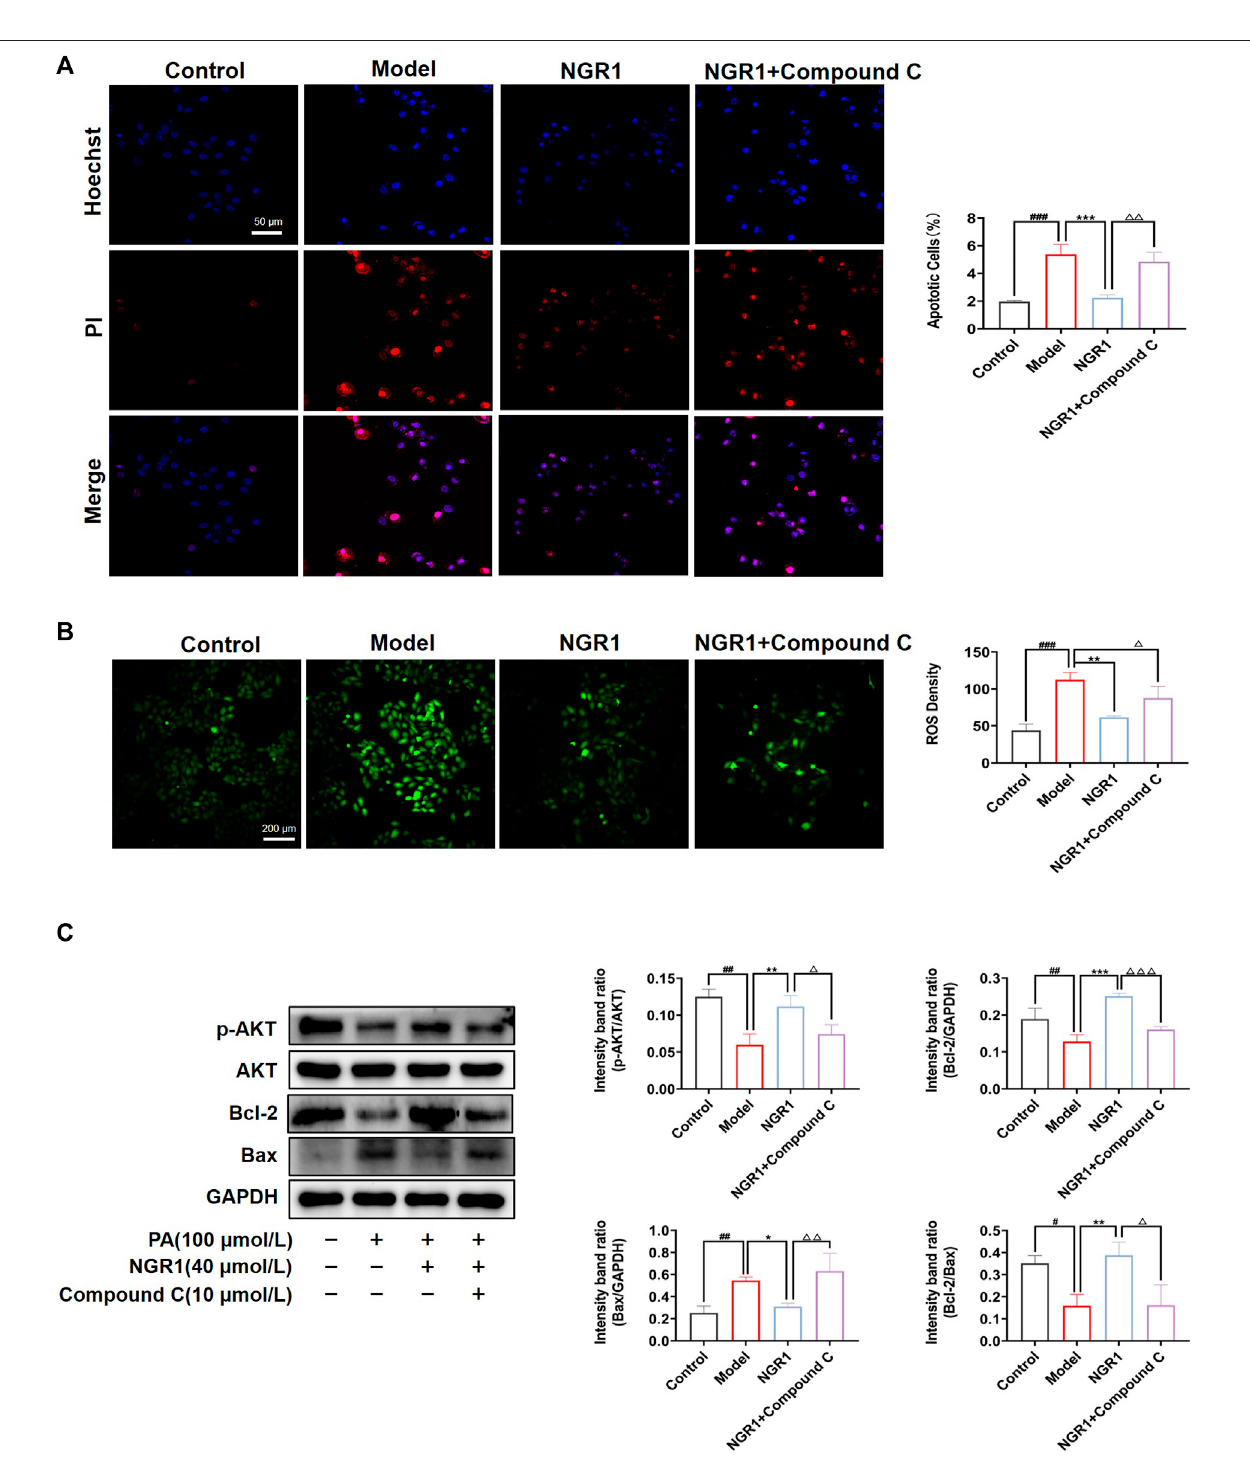
FIGURE 6 | Effects of NGR1 on oxidative stress and apoptosis. (A) Representative images of Hoechst 33342/PI staining and quantitative analysis. Scale bar = 50 μ m. (B) RepresentativeimagesofROSstaininginPA-induced H9C2cellswiththetreatmentofNGR1.Scalebar =200 μ m. (C) Westernblotanalysisofp-AKT,AKT, Bcl-2andBaxproteinlevelsinH9C2treatedwithNGR1.GAPDHservedastheinternalcontrol,* p < 0.05,** p < 0.01,*** p < 0.001vs.modelgroup, # p < 0.05, ## p < 0.01, ### p < 0.001 vs. control group, △ p < 0.05, △△ p < 0.01, △△△ p < 0.001 vs. NGR1 group. The experiments were repeated three times independently.